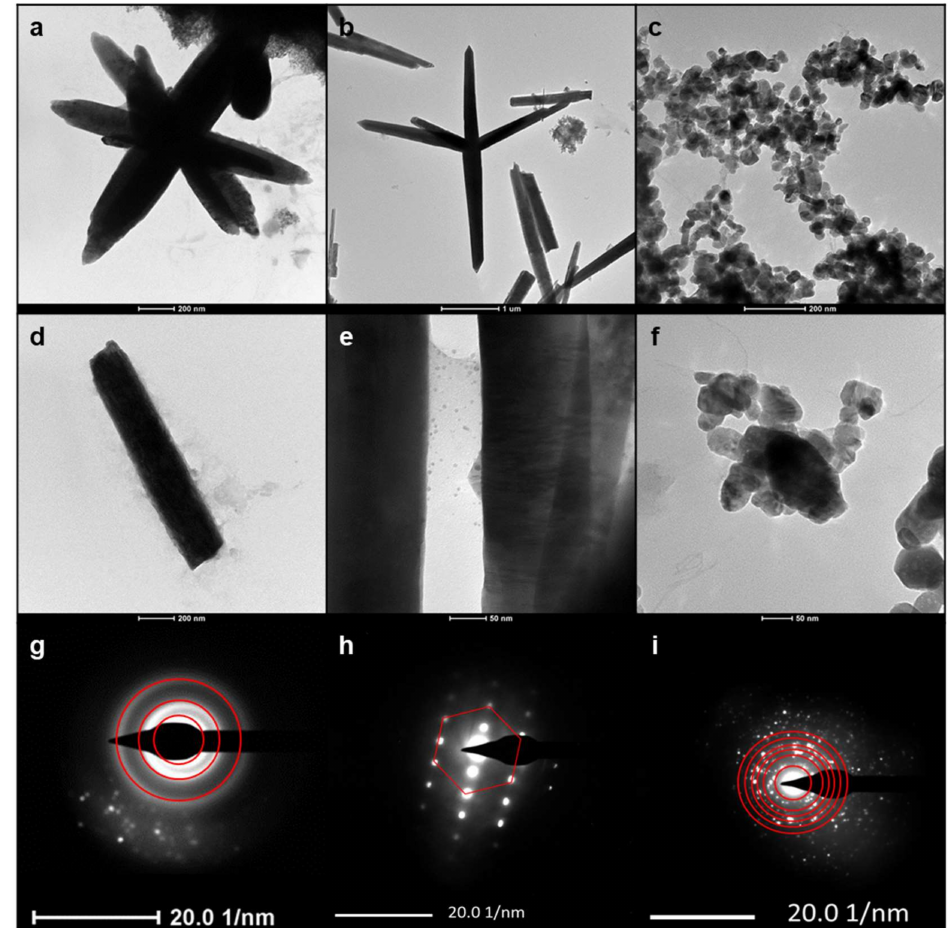
Figure 2. TEM micrographs of ( a , d ) CTAB-, ( b , e ) PDDA-, and ( c , f ) PSS-stabilized ZnONPs; SAED patterns of ( g ) CTAB-, ( h ) PDDA-, and ( i ) PSS-stabilized